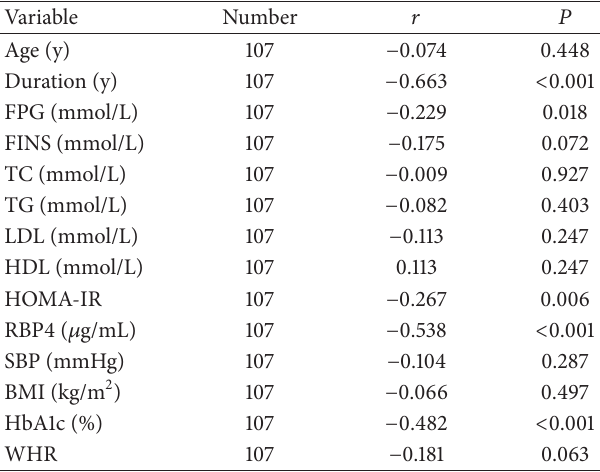
Table 4: The analysis of the correlation between 25(OH)D and the indicators of patients in Group